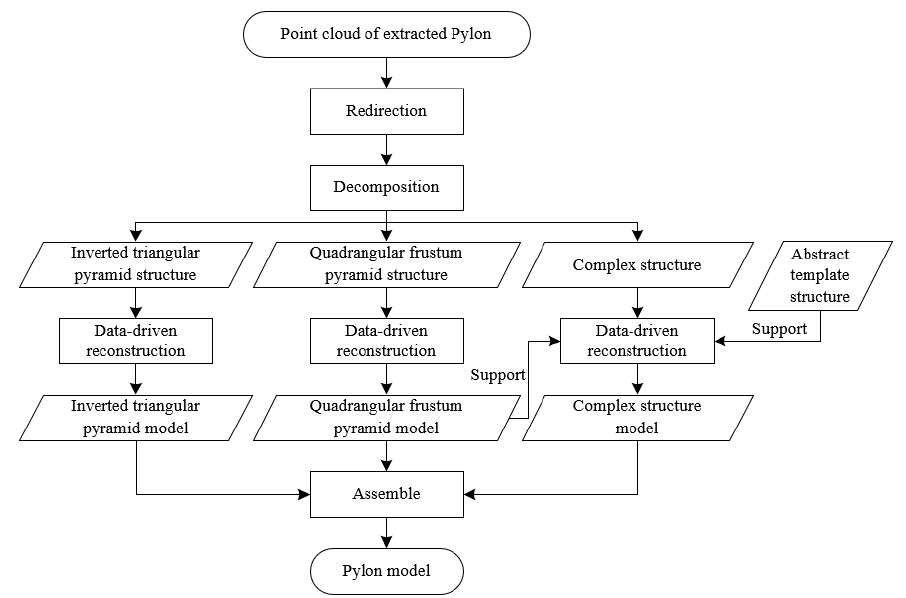
Figure 1. The flowchart of power pylon reconstruction algorithm.